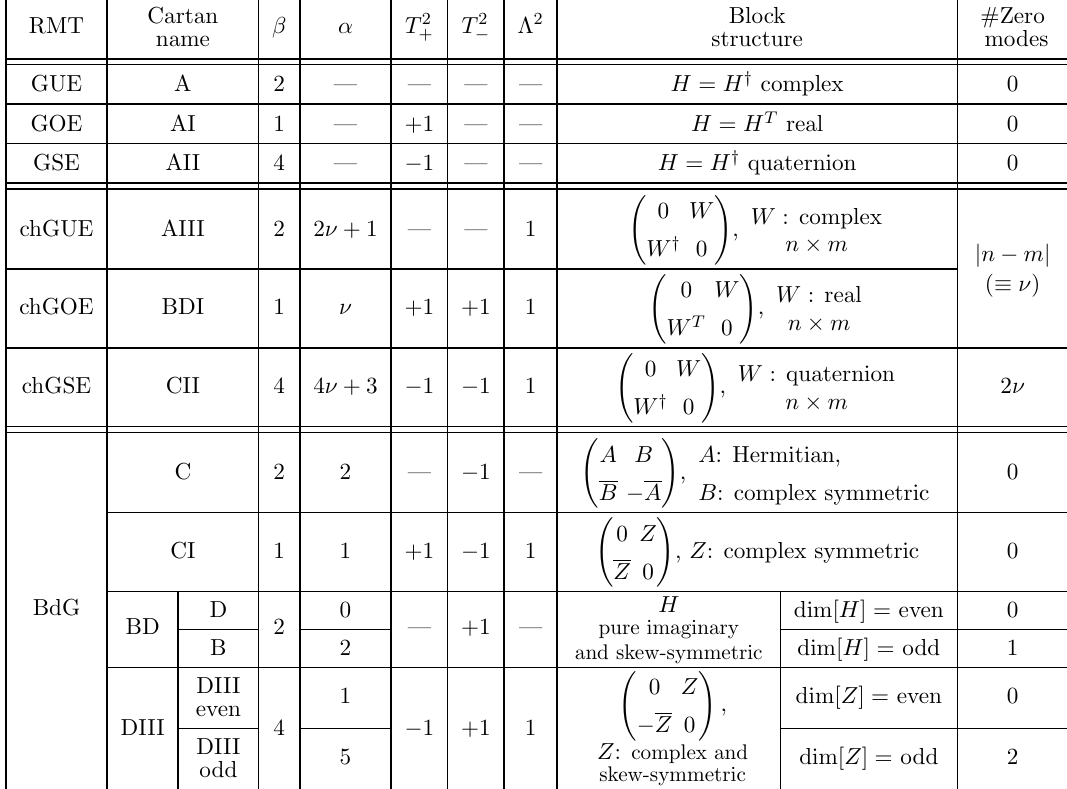
Table 1 . Classi(cid:12)cation of RMT symmetry classes. In the (cid:12)rst three rows we list the Wigner-Dyson classes. (cid:12) is the Dyson index de(cid:12)ned in the main text. In the remaining rows we list the chiral and BdG classes. The joint probability density for energy levels in these ensembles assumes the form P ( (cid:21) ) / Q j (cid:21) 2 (cid:0) (cid:21) 2 j (cid:12) Q j (cid:21) n j (cid:11) , and the indices (cid:12) and (cid:11) are presented in the third and fourth i j i<j n column, respectively. (cid:11) is related to the number of exact zero modes. The index (cid:23) de(cid:12)ned in the last column is related to the topological charge of the gauge (cid:12)eld in non-Abelian gauge theories. Here we de(cid:12)ne (cid:23) to be nonnegative. The symbol \|" implies that there is no symmetry in that class. The classes B and DIII-odd are sometimes omitted in other references, but we include them here for completeness. T + ( T (cid:0) ) denotes an antiunitary operator that commutes